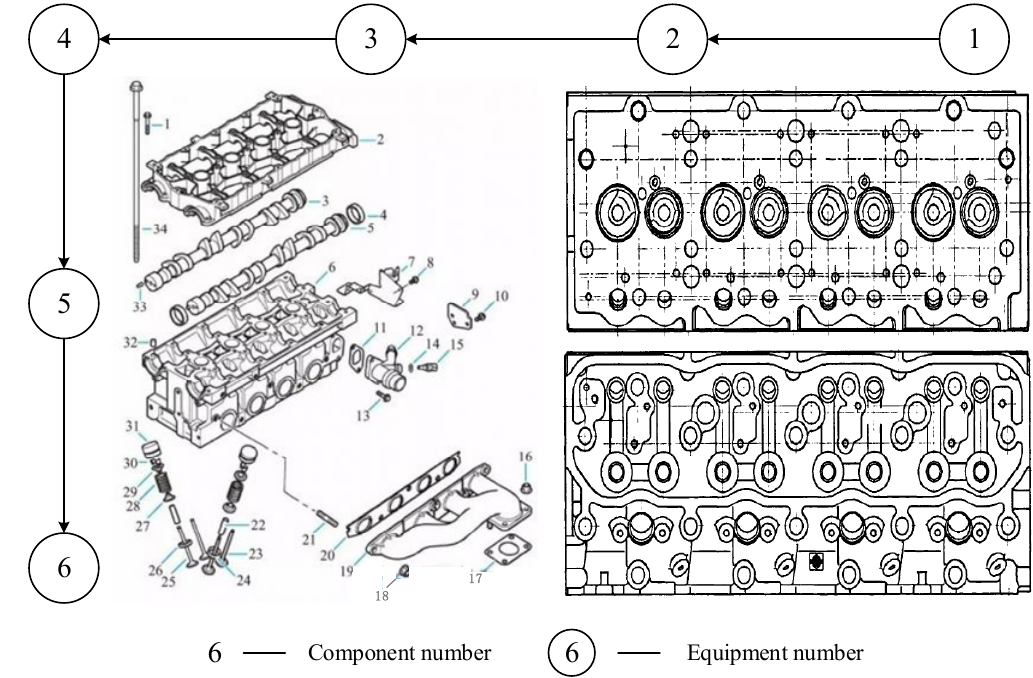
Figure 7. Structure and sectional view of the engine cylinder head assembly. Table 1. Risk parameter values.